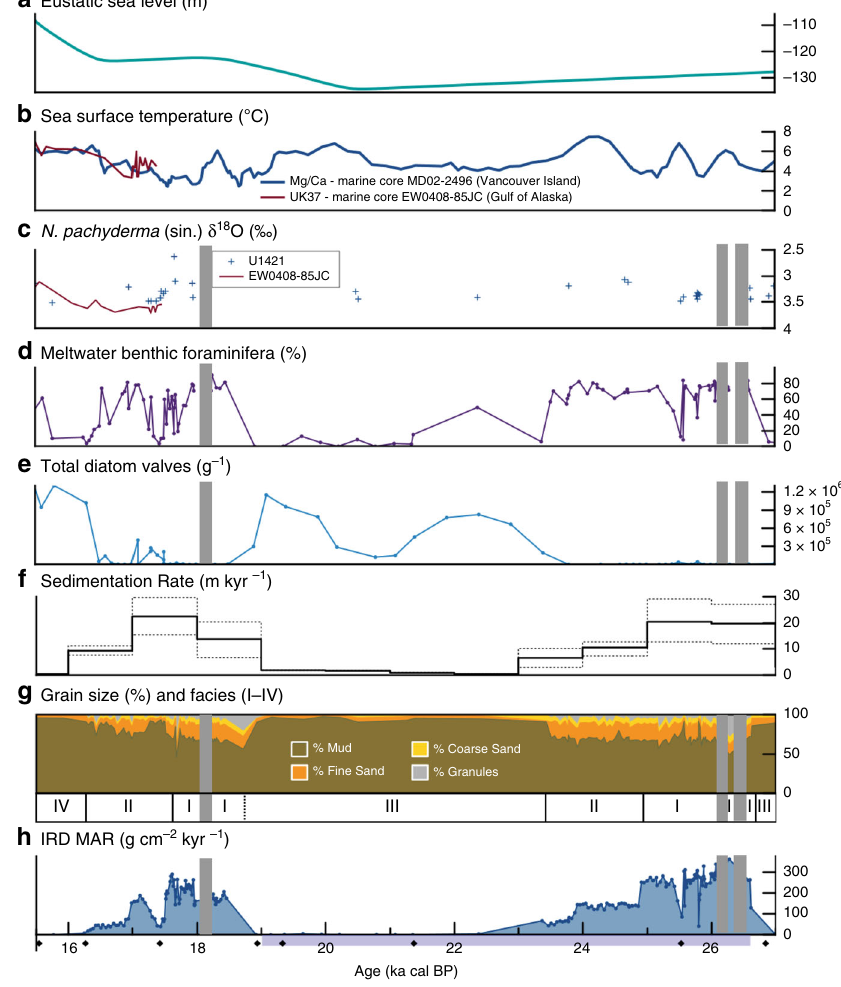
Fig. 2 Multiproxy records from slope Site U1421 from 27 to 15 kyr ago. a Global mean sea level curve (m) 24 . b Regional sea surface temperature proxies from EW0408-85JC 26 and MD02-2496 25 (Fig. 1). Mg/Ca values plotted using 4-pt moving average. c Values for δ 18 O analysis of N. pachyderma (sin.) in samples from site U1421 and survey site EW0408-85JC 27 . Error bars (±1 sigma) are smaller than symbol size. d Percentage of benthic foraminifera indicative of meltwater. e Diatom valves per gram sediment. f Mean sedimentation rates (m kyr − 1 ) binned at 1000-year intervals. One-sigma error is denoted by the dashed lines. g Distribution of grain sizes and lithofacies (I – IV). h Ice-rafted debris mass accumulation rate (g cm − 2 kyr − 1 ). Gray shaded areas are intervals of no core recovery. Black diamonds are radiocarbon dates. Last Glacial Maximum from 26.5 to 19 ka cal BP 14 is shown by purple